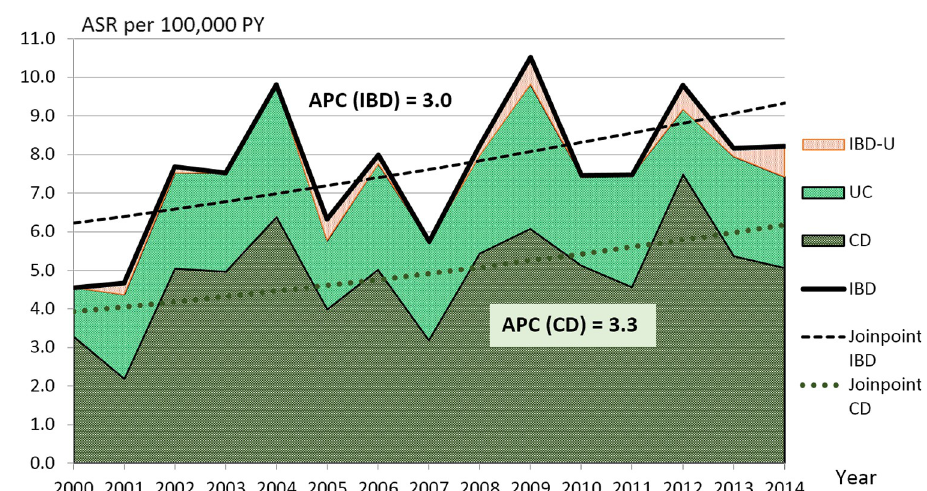
Fig 1. Incidence trends of age-standardized incidence rates (ASR per 100,000 PY) in Saxony, Germany by joinpoint regression, stacked presentation with IBD and CD joinpoint trend lines and corresponding annual percent change (APC) values. Inflammatory bowel disease (IBD), Crohn’s disease (CD), ulcerative colitis (UC) and unclassified IBD